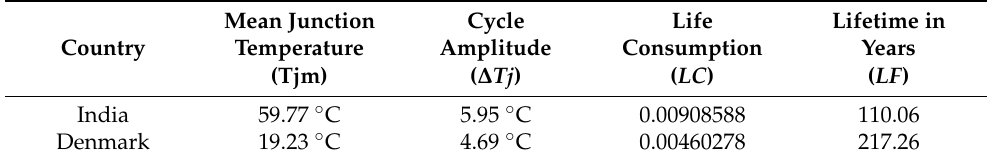
Table 3. Lifetime evaluation considering a monofacial PV panel.